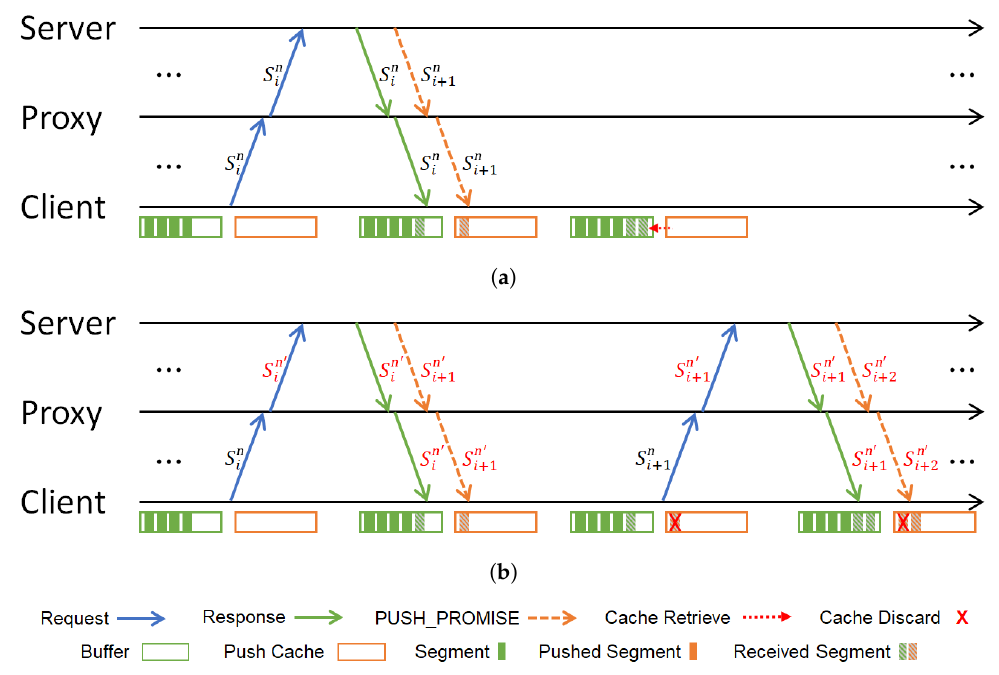
Figure 3. Example requests/responses flows in adaptive streaming over HTTP/2 with server push when ( a) proxy only forwards the client’s request and ( b ) proxy overwrites the client’s